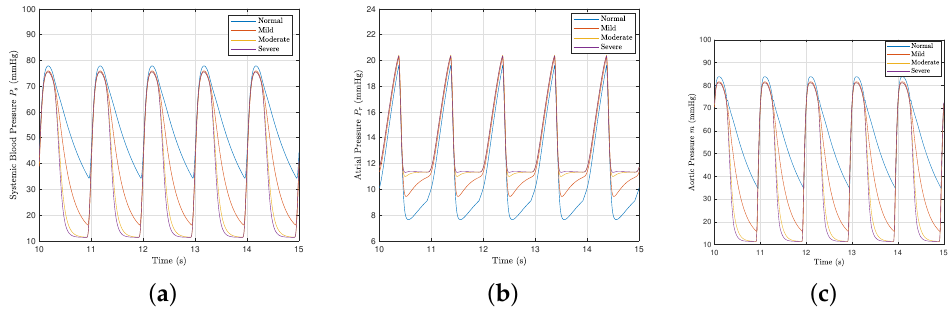
Figure 7. Systemic, atrial, and aortic pressures with aortic valve regurgitation. ( a ) Systemic blood pressure P s . ( b ) Atrial pressure P r . ( c ) Aortic pressure m .